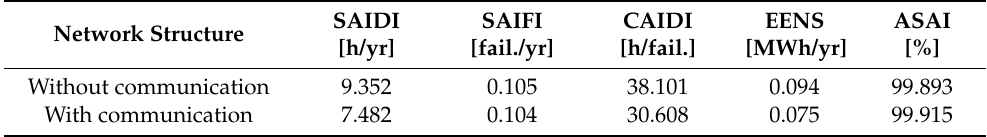
Table 14. Average system indices for the electric power system analyzed.